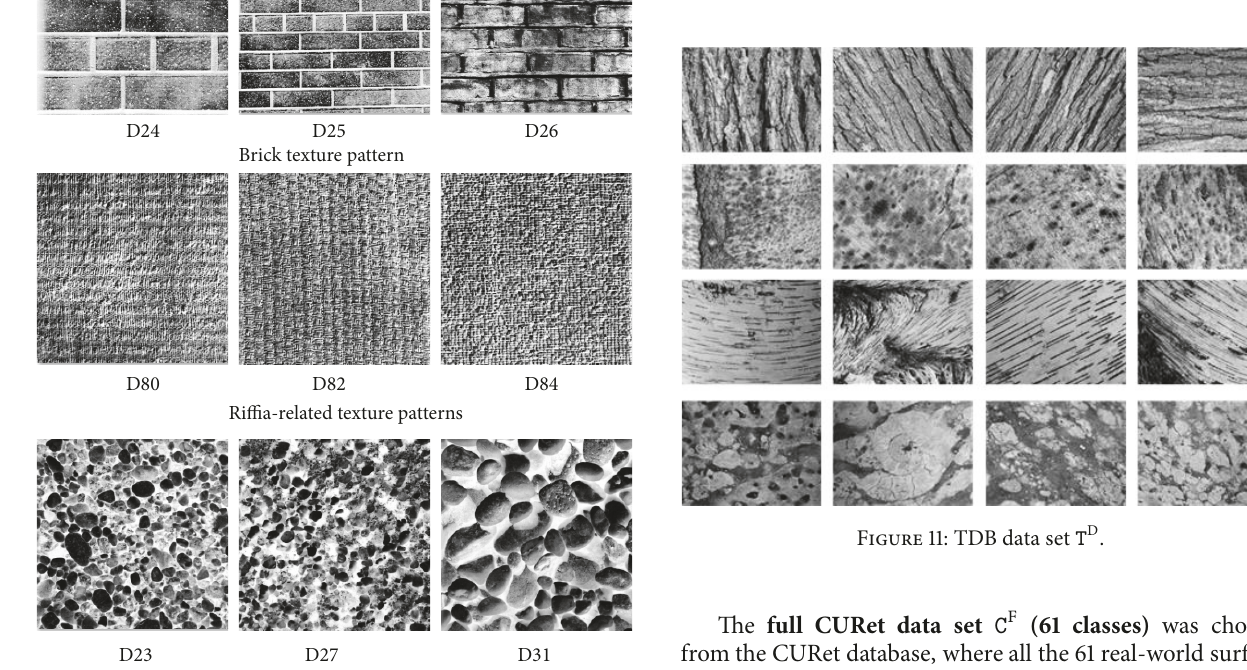
Figure 10: 20-class texture patterns of C Sc .